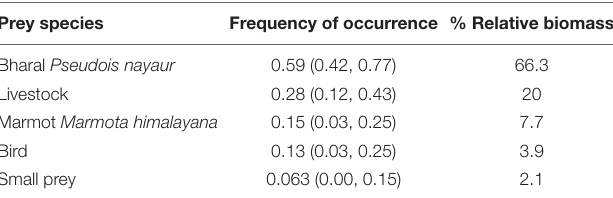
TABLE 7 | Content of 32 woolly wolf scats in the Gangotri National Park, Uttarakhand, India, with the mean percentage frequency of prey items (with 95% confidence intervals, CI, from bootstrapping), estimated% relative biomass of the prey